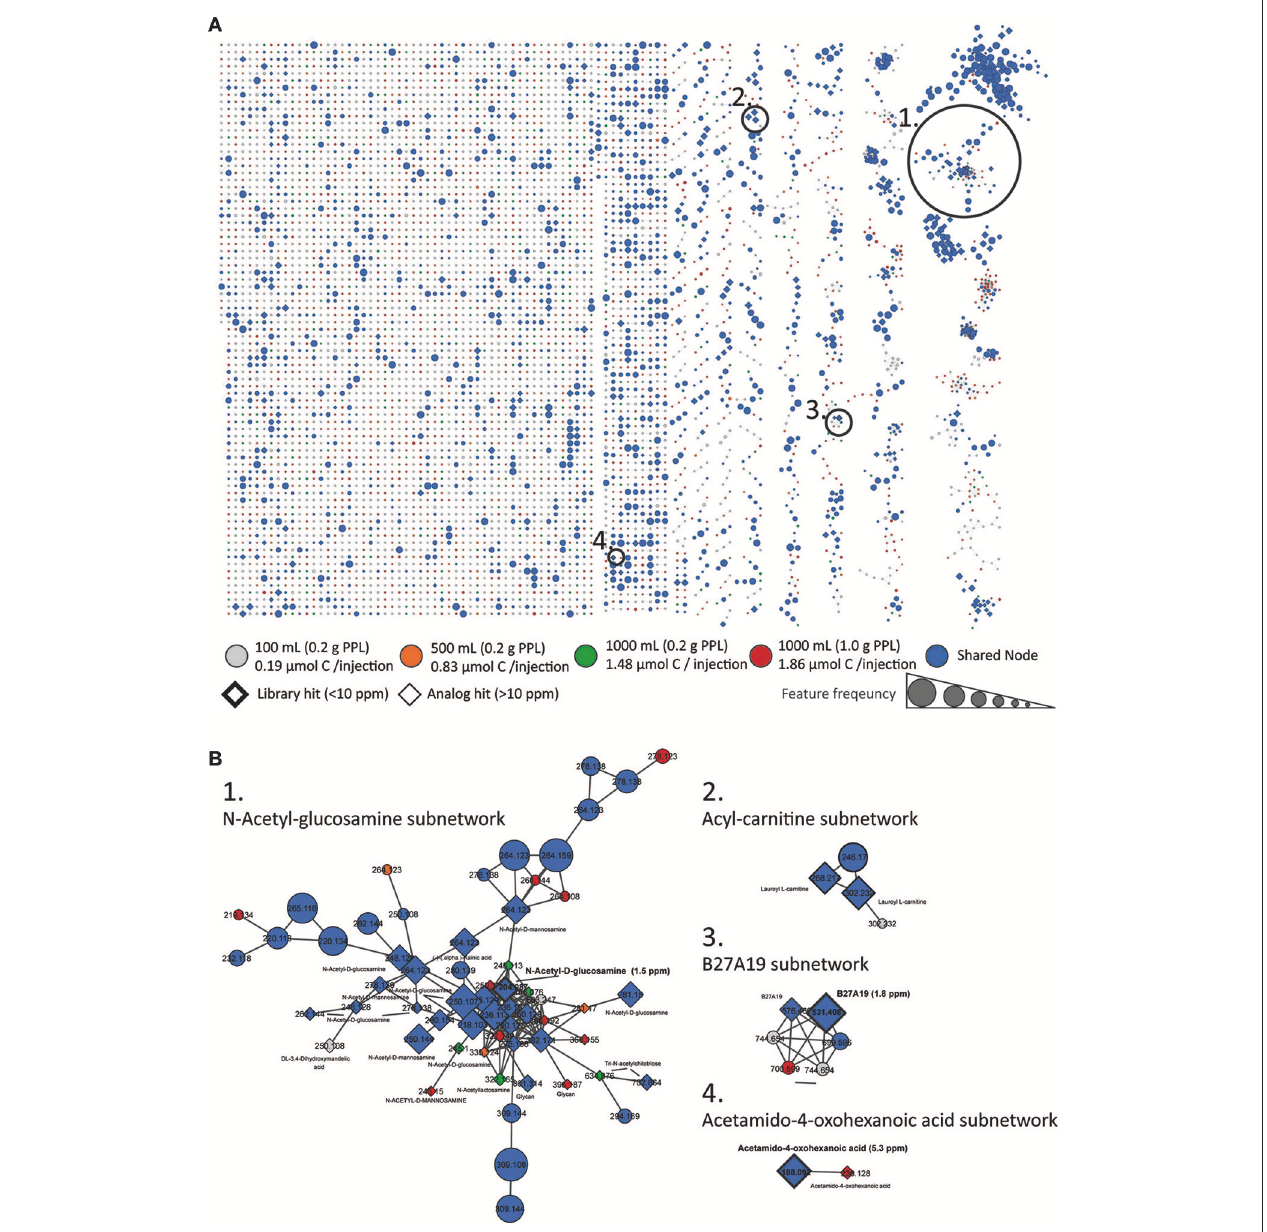
FIGURE 4 | Molecular Network. Global spectral network from all sample groups is shown in (A) . Nodes from blanks were subtracted. According to origin, nodes were labeled gray (100mL, 0.2g PPL, 0.19 µ mol injected C), orange (500mL, 0.2g PPL, 0.83 µ mol injected C), green (1,000mL, 0.2g PPL, 1.46 µ mol injected C) and red (1,000mL, 1g PPL, 1.86 µ mol injected C) if spectra came exclusively from this group. If a node was shared between two or more groups it was labeled blue. The size of the nodes represents the sample frequency, i.e. the number of samples which contained a particular MS/MS spectrum. Nodes with a library hit are displayed in diamond shape with a thick boarder line if the precursor matched within 10 ppm and with a thin line for hits with higher delta masses (from analog search). In (B) zoomed subnetworks of selected molecular families are shown.